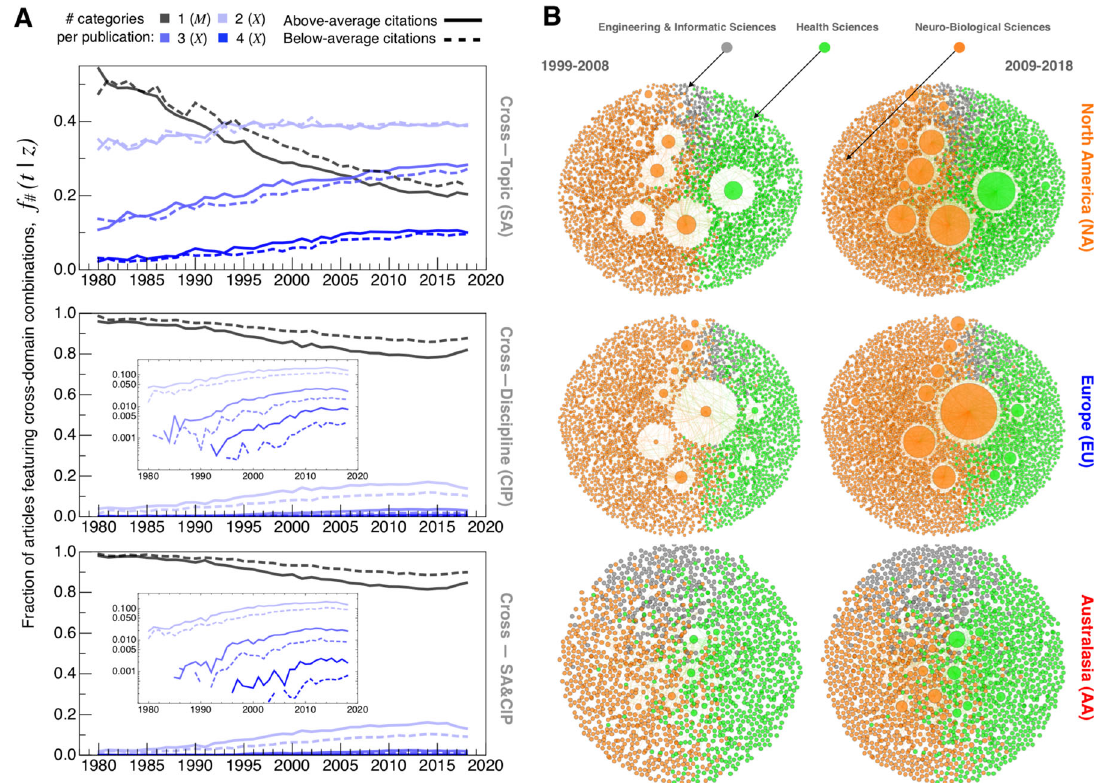
Fig. 2 Trends in cross-domain scholarship in Human Brain Science. A Fraction f # ( t ∣ z ) of articles published each year t that feature a particular number ( # ) of categories. Articles are split into an above-average citation subset ( z p > 0) and below-average citation subset ( z p < 0). Upper panel: Articles categorized by SA. Middle panel: Articles categorized by CIP; subpanel shows data on the logarithmic y-axis; Lower panel: Articles categorized by both SA and CIP. Distinguishing frequencies by citation group indicates higher levels of cross-domain combinations among research articles with higher scienti fi c impact — for both SA and CIP. However, cross-domain activity levels are visibly higher for SA than for CIP, indicating higher barriers to boundary-crossing arising from mixing different scholar expertise. B Snapshots of the collaboration network at 10-year intervals indicating researcher population sizes by region, and the densi fi cation of convergence science at cross-disciplinary interfaces. Nodes (researchers) are sized according to the number of collaborators (link degree) within each time